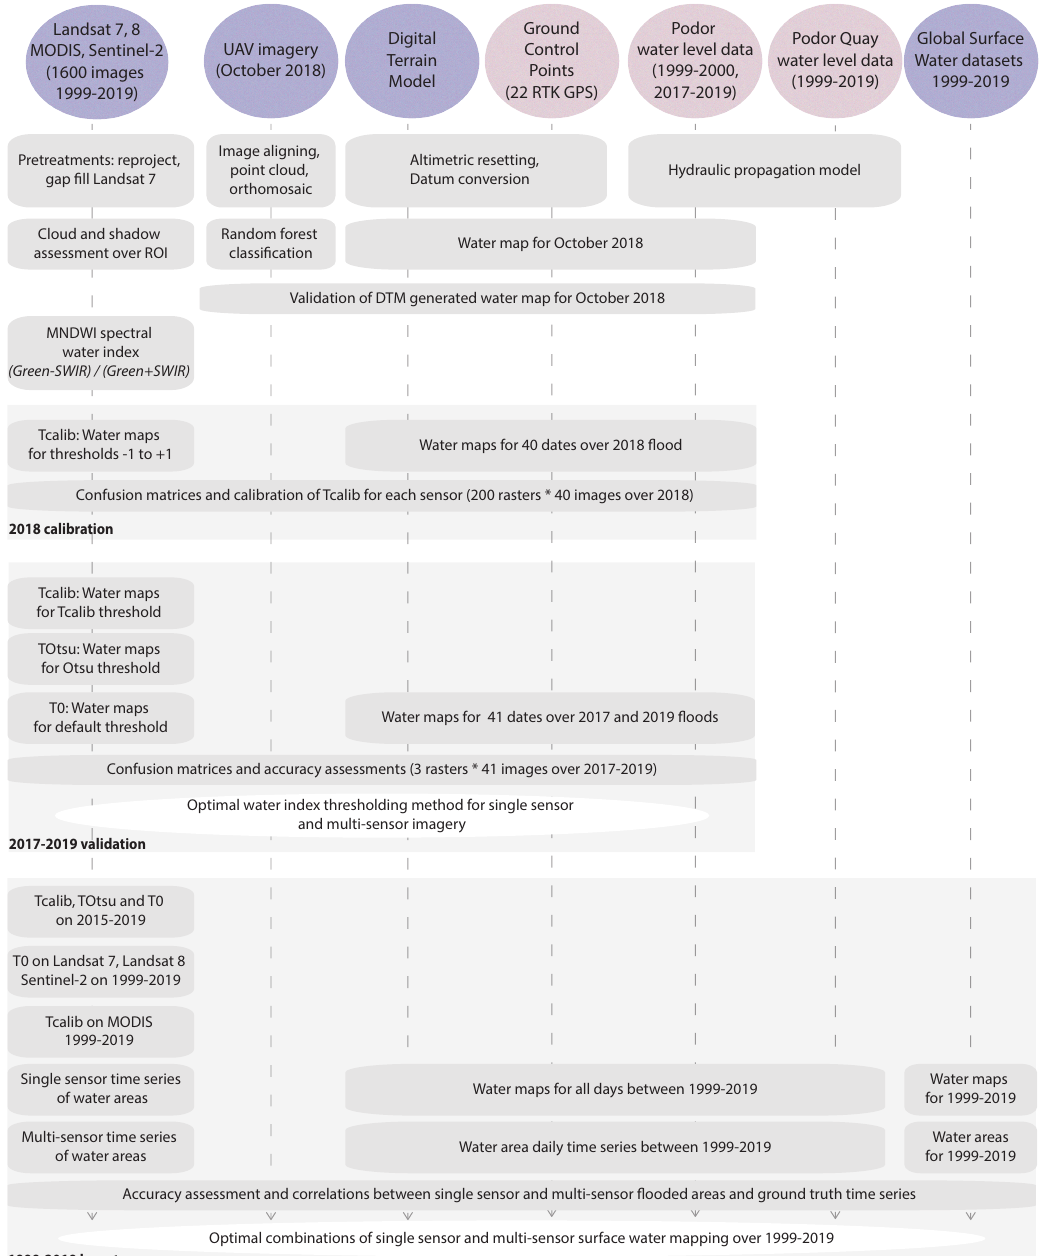
Figure 2. Conceptual flowchart of the methods and data used to investigate the accuracy of spectral water index thresholding methods and optimal combinations of single sensor and multi-sensor